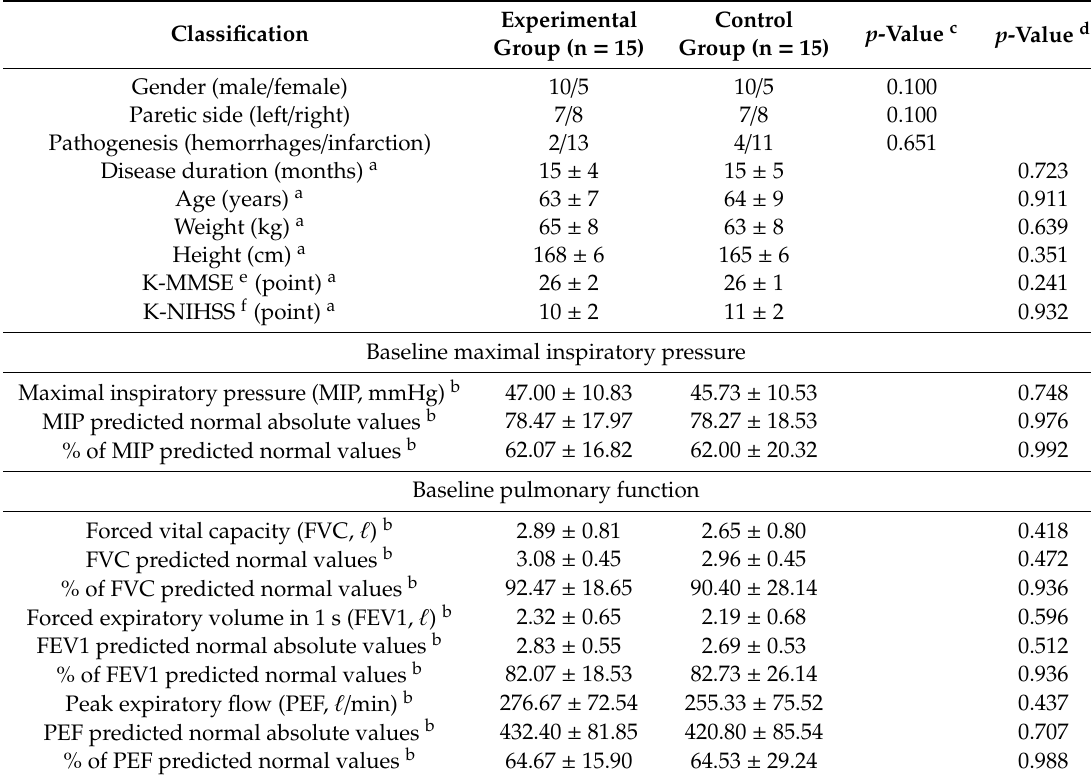
Table 1. Subject